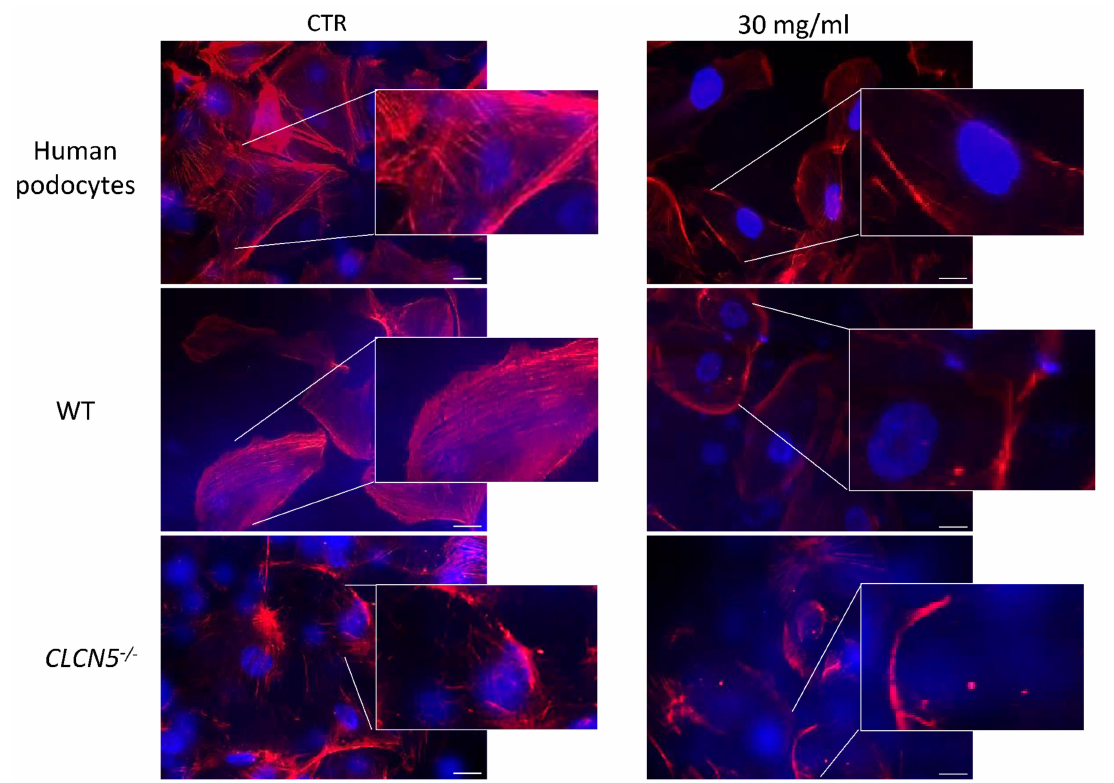
Figure 12. Phalloidin fluorescence labelling of F-actin of human podocytes, WT (clones subjected to CRISPR/Cas9 editing but without mutation), and mutant clones ( CLCN5 − / − ) after exposure to